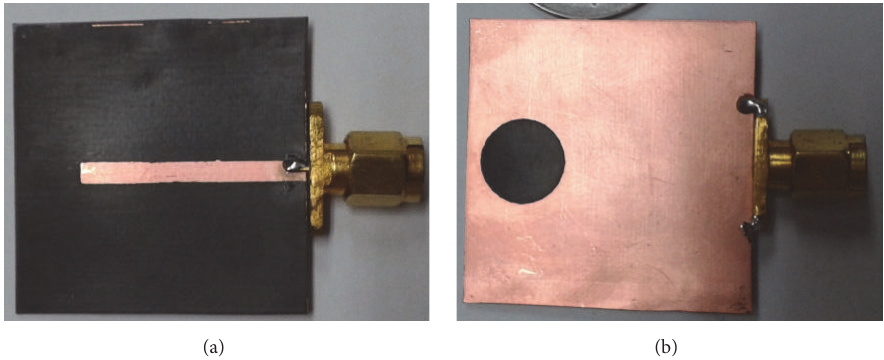
Figure 29: Fabricated prototype of [97]. (a) Top view. (b) Bottom view.